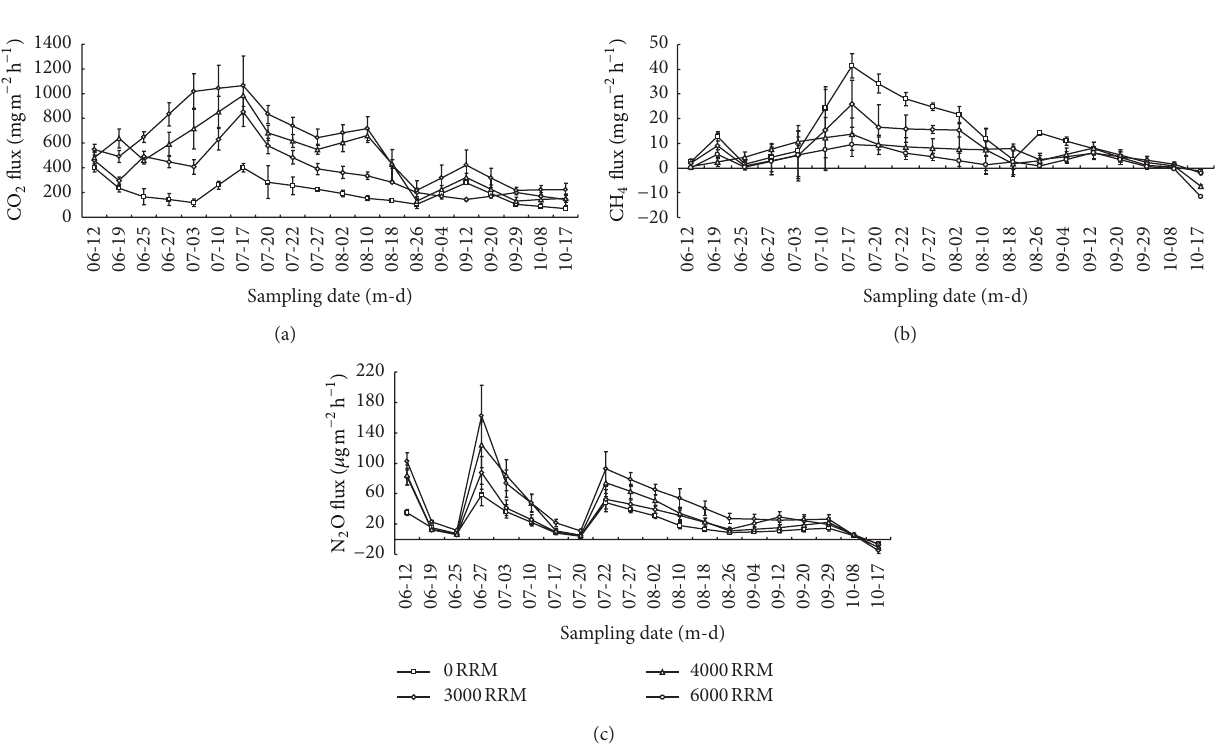
Figure 2: Changes in soil CO 2 (a), CH 4 (b), and N 2 O (c) fluxes from NT paddy fields under different residue mulching treatments during the rice-growing season. The vertical bars are standard deviations of the mean, 𝑛 = 3